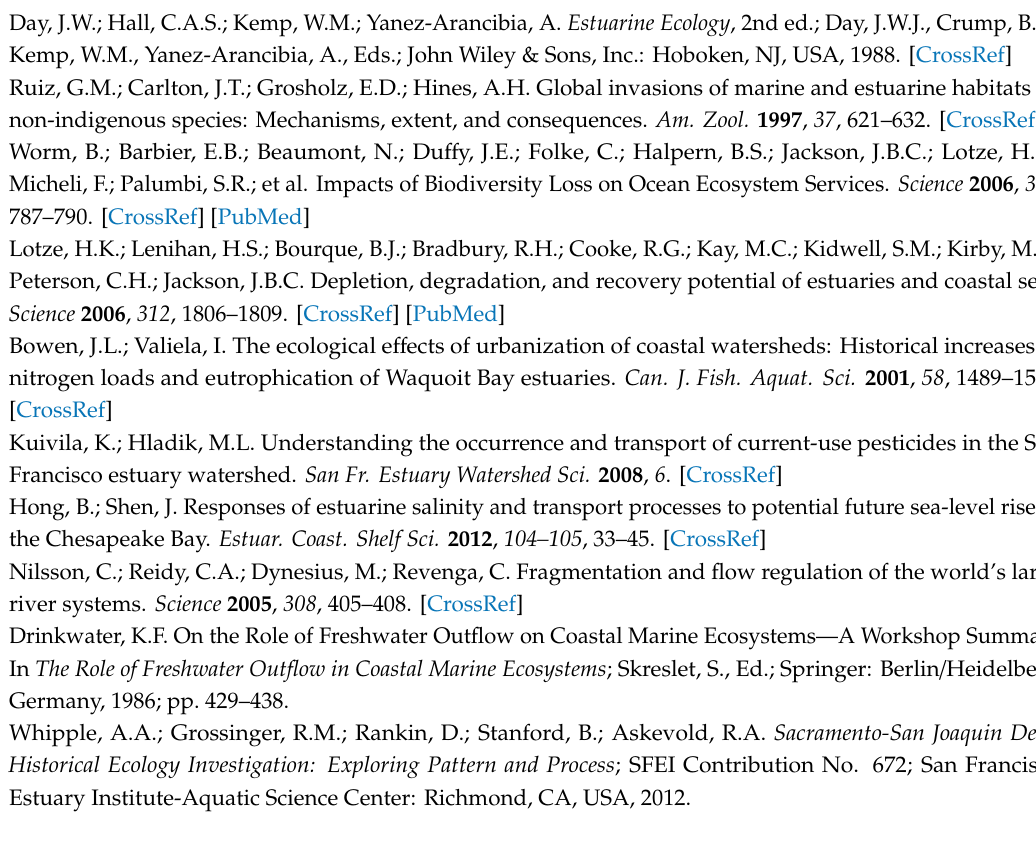
Table S1: Field δ 2 H and δ 18 O isotope data for all